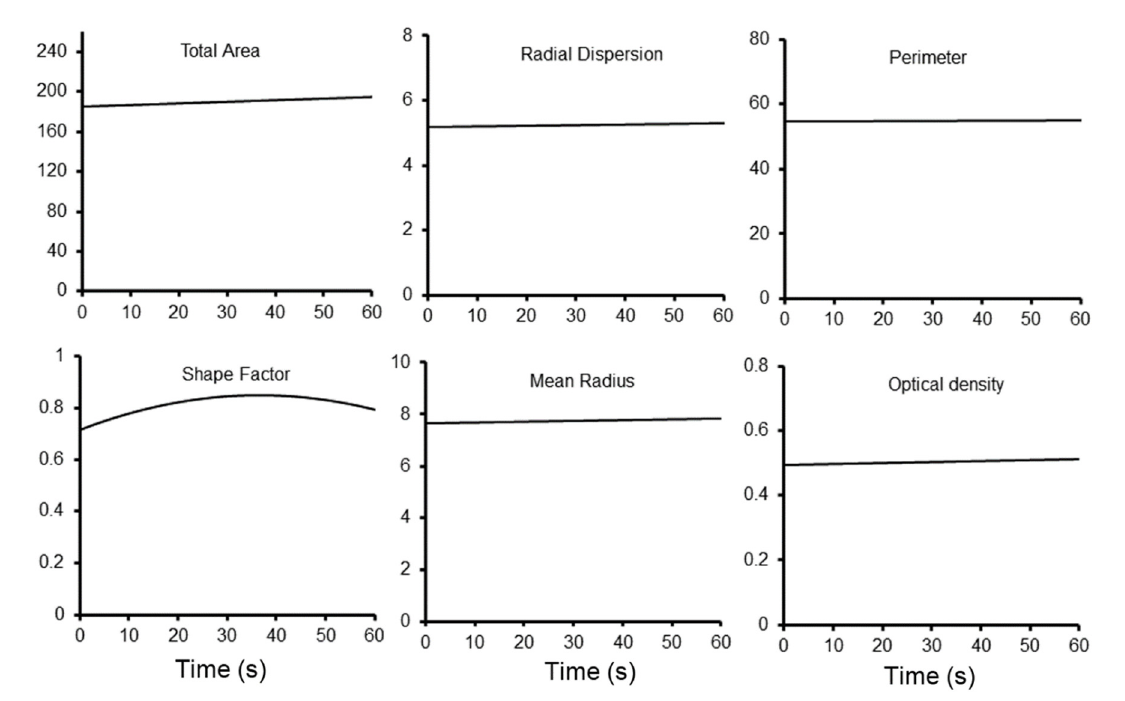
Figure 7. Morphometric analysis of methylene blue loading with variable contact time. The mor- phometry measures did not demonstrate any dependence on contact time. A minimum of 15 s appeared to be required to insure adequate wetting. The curves reflect the aggregate best fit curve based on replicate measures of probe velocity and compressive force.